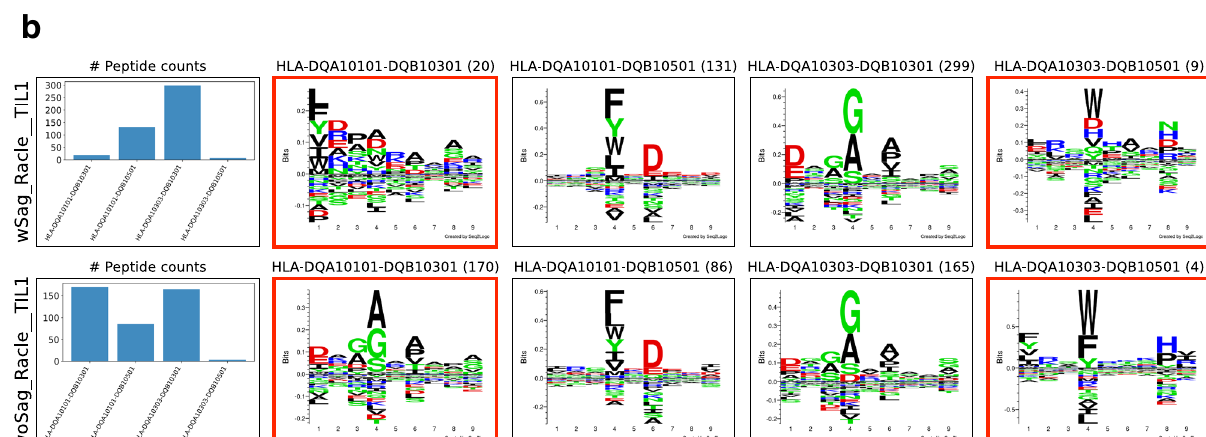
proportion of peptides (170 out of 425) to HLA-DQA1 * 01:01- DQB1 * 03:01, which is a trans-only molecule known to not form a stable heterodimer 12,13 . On the other hand, in the model trained with the novel data, almost no peptides are assigned to this molecule (20 out of 459). Instead, the peptides are assigned to the cis molecule HLA-DQA1 * 03:03-DQB1 * 03:01. Note, also, that for both models a very minor proportion of peptides are assigned to HLA-DQA1 * 03:03-DQB1 * 05:01, another trans-only heterodimer known to be unstable 12,13 .